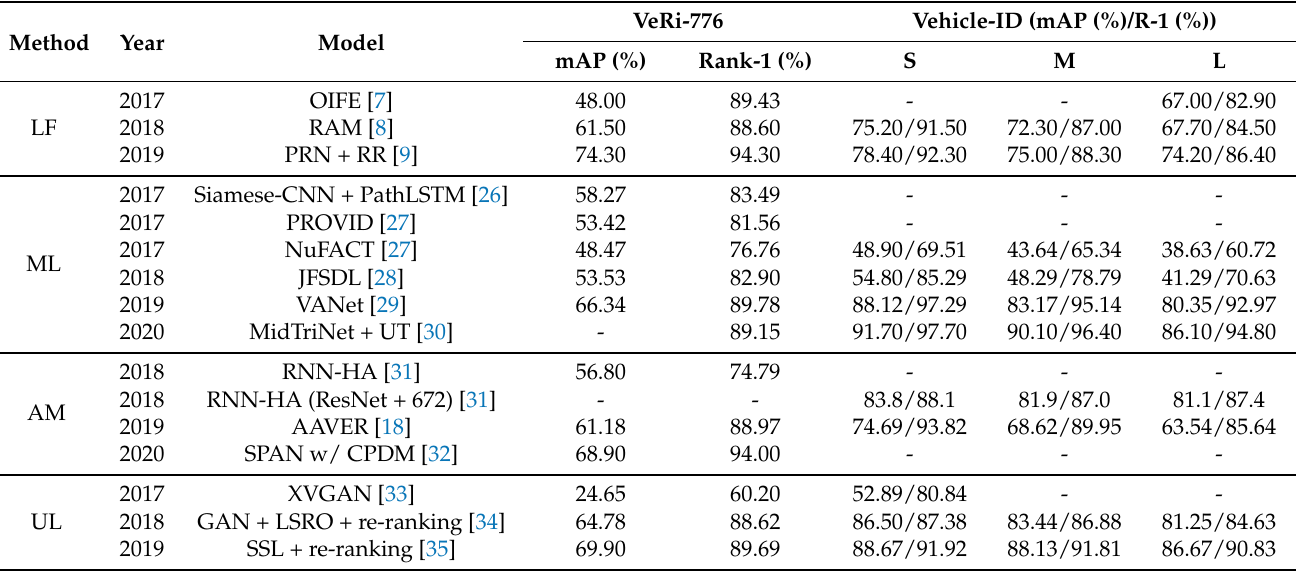
Table 3. Summary of some results on vehicle re-identification in a closed-set environment